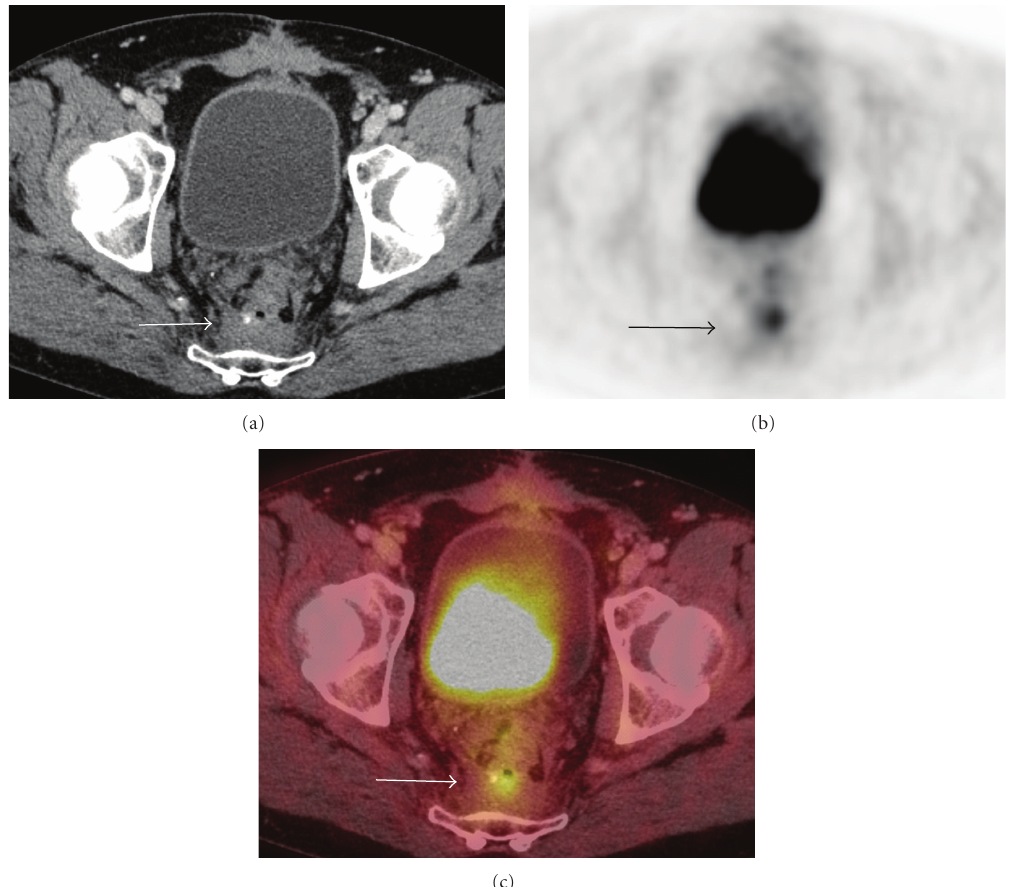
Figure 8: Local recurrence 2 years following resection of rectal carcinoma. (a) There is soft tissue material in the presacral space (arrow) that may be postoperative in nature but the presence of malignancy is di ffi cult to exclude on CT alone. (b) There is a small focus of avid radiotracer uptake (arrow) on the on FDG-PET. (c) Increased uptake on FDG-PET (arrow) correlates with the presacral soft tissue (arrow) and is characteristic of tumor recurrence in a patient who has not had recent surgery in this area and has no symptoms of leak or